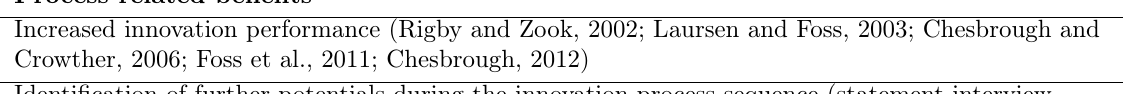
Table 3. Process-related benefits of open